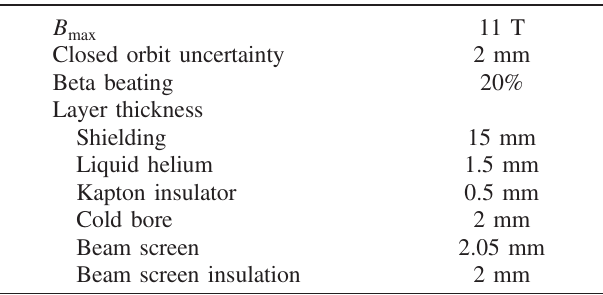
TABLE III. Parameters used for the beam stay clear